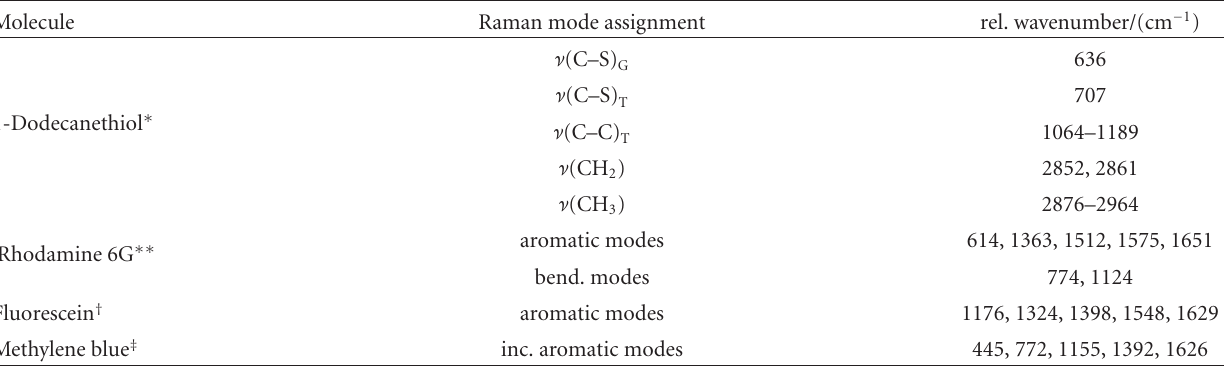
Table 1: Some of the most strong Raman modes and corresponding wavenumbers. ∗ Data taken from Bryant and Pemberton [46]. ∗∗